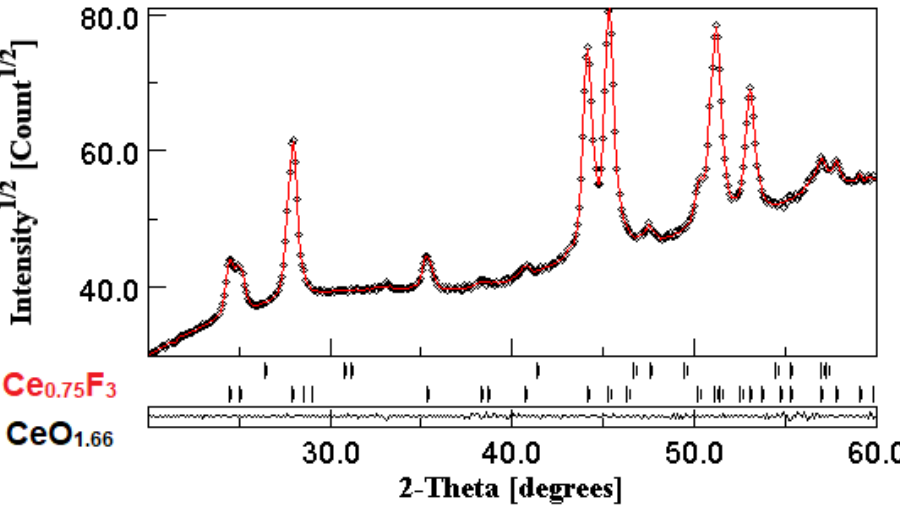
Figure 1. XRD pattern (black curve) and Rietveld refinement plot (red curve) of CeF 3 :Tb nanocrystalline powder calcinated at 400 °C, with the Bragg reflections for Ce 0.75 F 3 and CeO 1.66 crystalline phases indicated by vertical bars; the lower trace represents the difference curve between observed and calculated patterns.